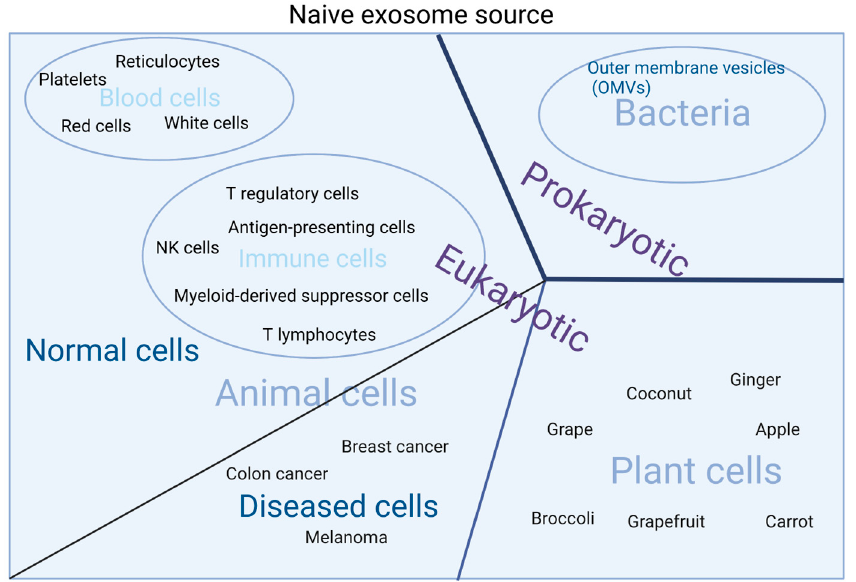
Figure 2. Primary sources of native exosomes.